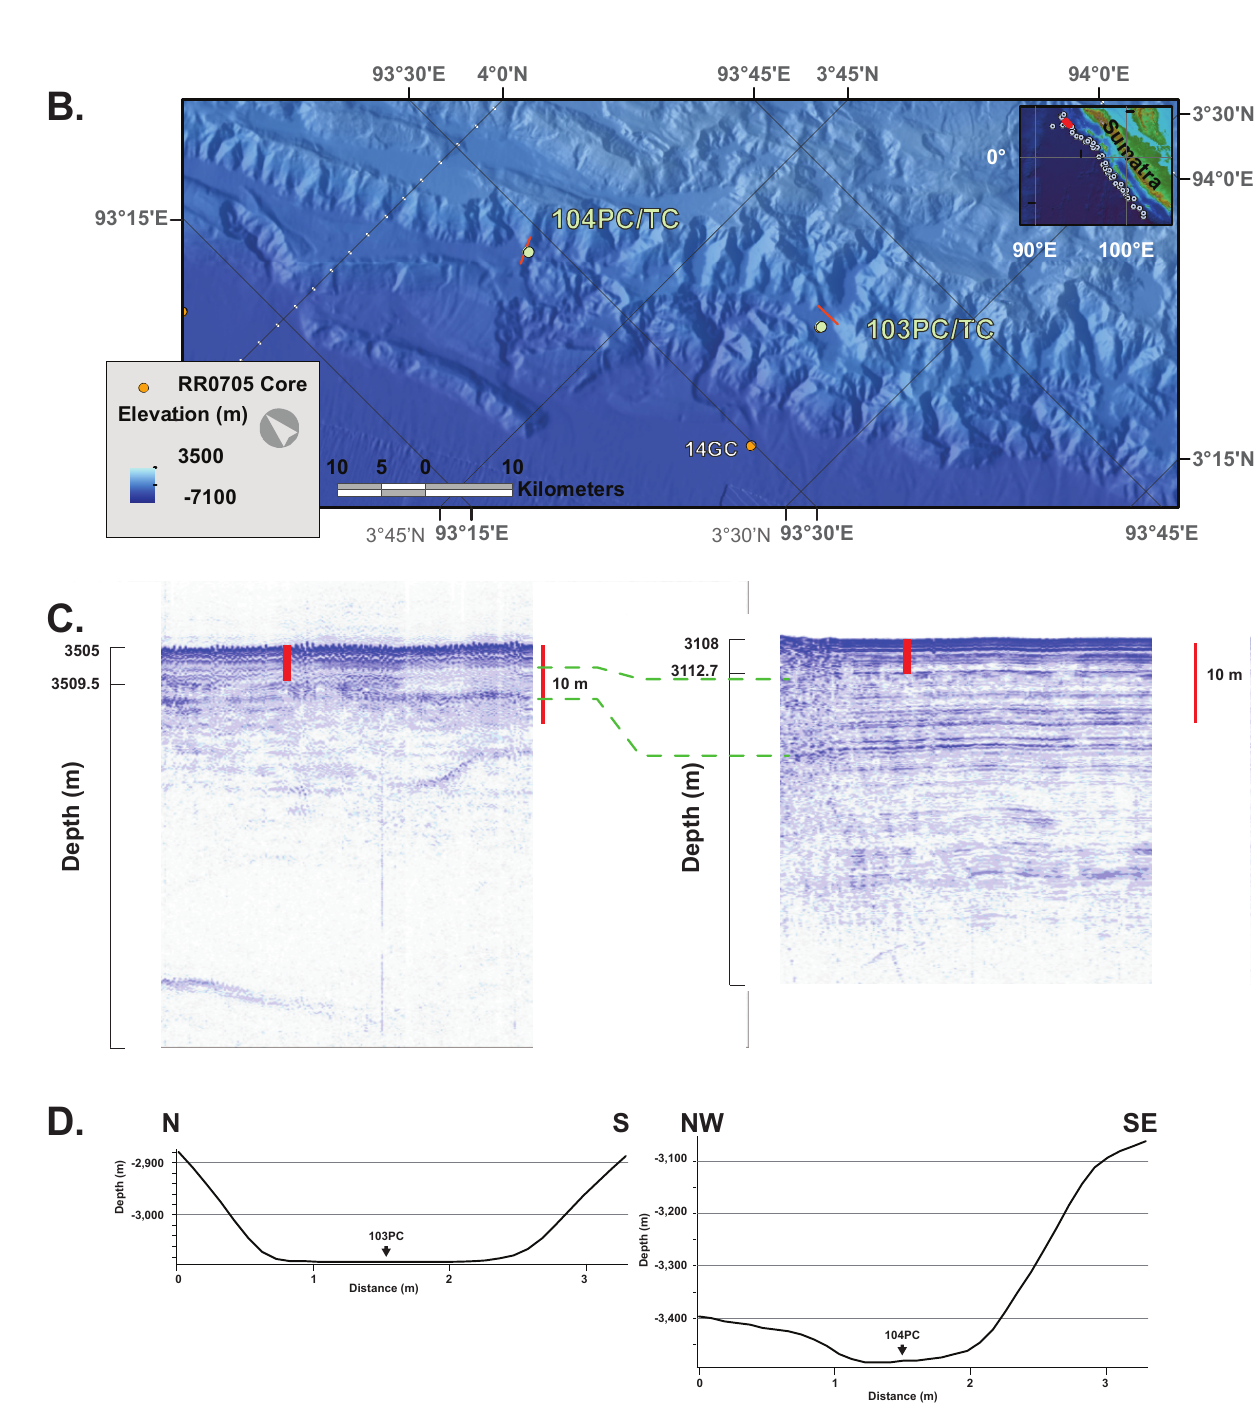
Fig. 5. (B) Core sites are plotted as orange circles on compiled bathymetry data set described in the text (Ladage et al., 2006). Inset map shows location of large map in red (northern margin) and cores in main map are orange dots. (C) 3.5kHz CHIRP seismic data collected at core sites are processed in SioSeis and plotted in SeiSee (seismic envelope). Core locations are designated by a red line scaled to core length. The x-axis for the seismic plots is not distance, but shot number. These seismic data were collected while the ship was staying on position during coring. (D) Elevation is plotted versus distance across the basins for cores 104 and 103. Profile locations are plotted as orange lines in (B)